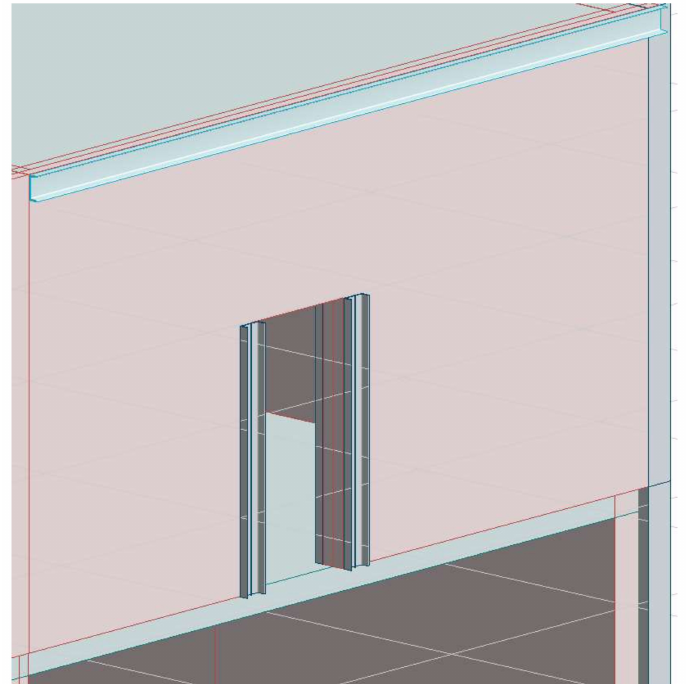
Figure 26. Modeled PSS (H1).